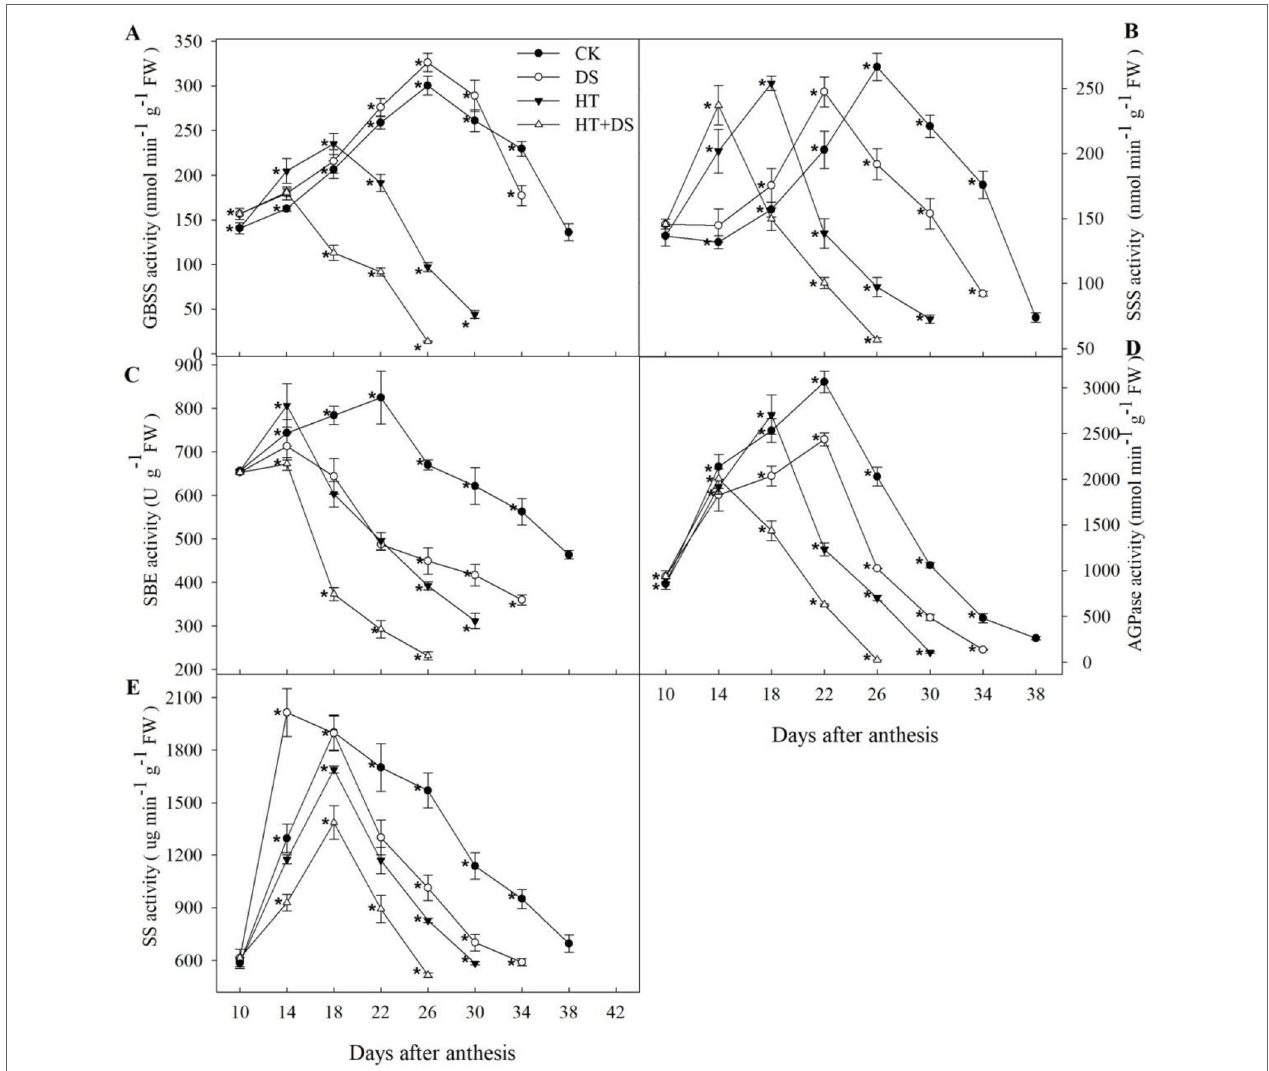
FIGUrE 3 | Dynamic changes in the activities of enzymes (A – E) related to starch biosynthesis in wheat endosperm from 10 to 42 days after anthesis in response to temperature and drought stress treatments. Filled circles, control (CK); open circles, drought treatment (DS); filled triangles, high temperature treatment (HT); open triangles, HT+DS treatment. Asterisks (*) indicate significant differences (p 0.05) between the individual treatments (CK, DS, HT,